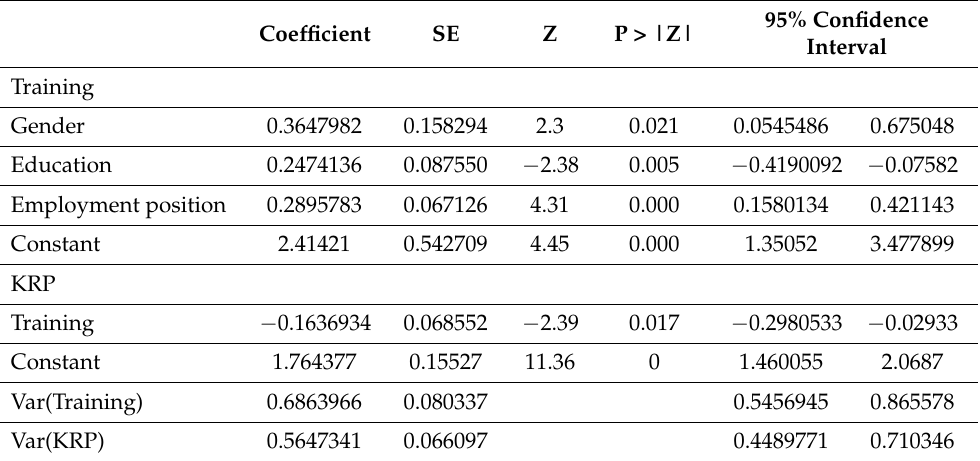
Table 4. Estimation structural equation model.